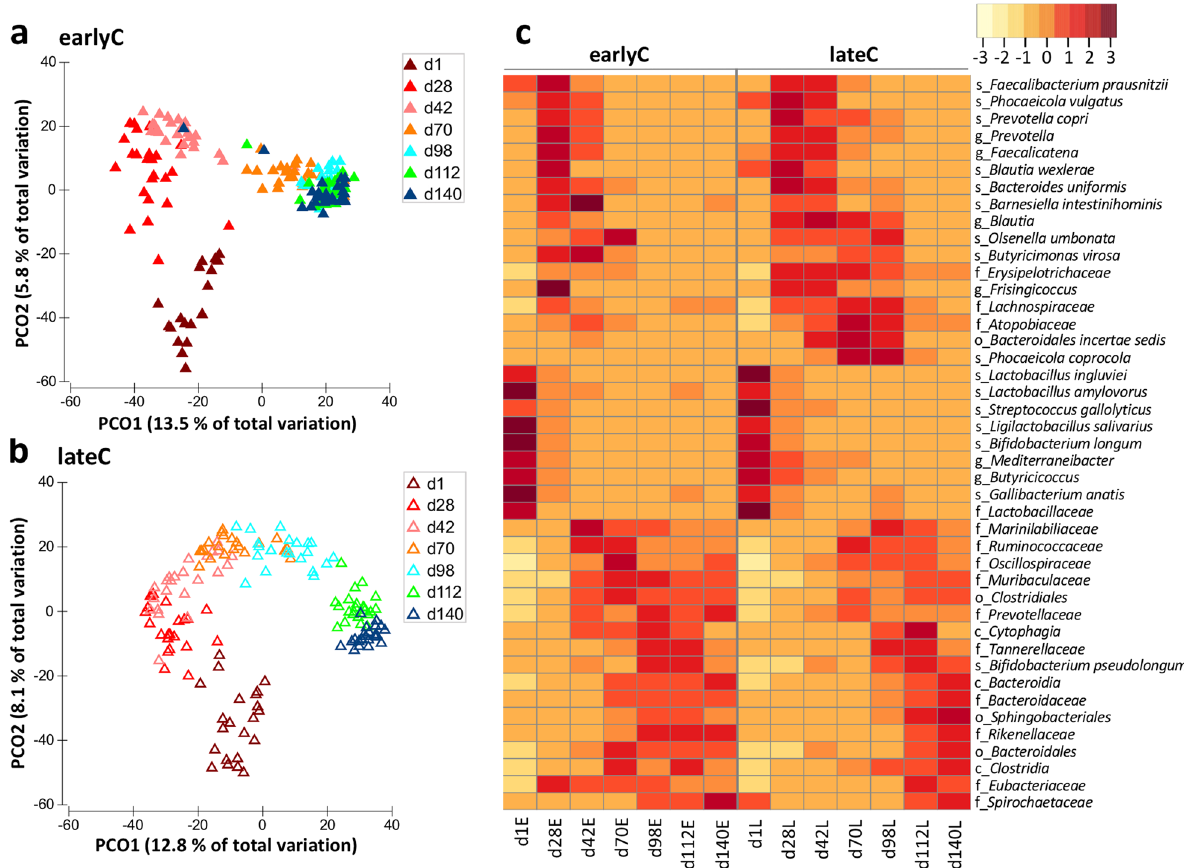
Fig. 1 Age‑dependent changes in the faecal bacterial communities of earlyC and lateC calves. a , b Bacterial compositional profiles of different age group earlyC ( n 176) and lateC ( n 154) faecal samples based on ASVs visualized using principal‑coordinate analysis plots. Each triangle indicates = = one sample. c Heatmap based on bacterial taxa with significantly different relative abundance ( p < 0.05; Kruskal–Wallis test). Each day represents an average value for animals: d1 (20 & 22), d28 (24 & 21), d42 (25 & 23), d70 (26 & 21), d98 (27 & 22), d112 (27 & 23), and d140 (27 & 22) animals for earlyC and lateC groups, respectively. EarlyC group was weaned during experimental days 28–42 and lateC during experimental days